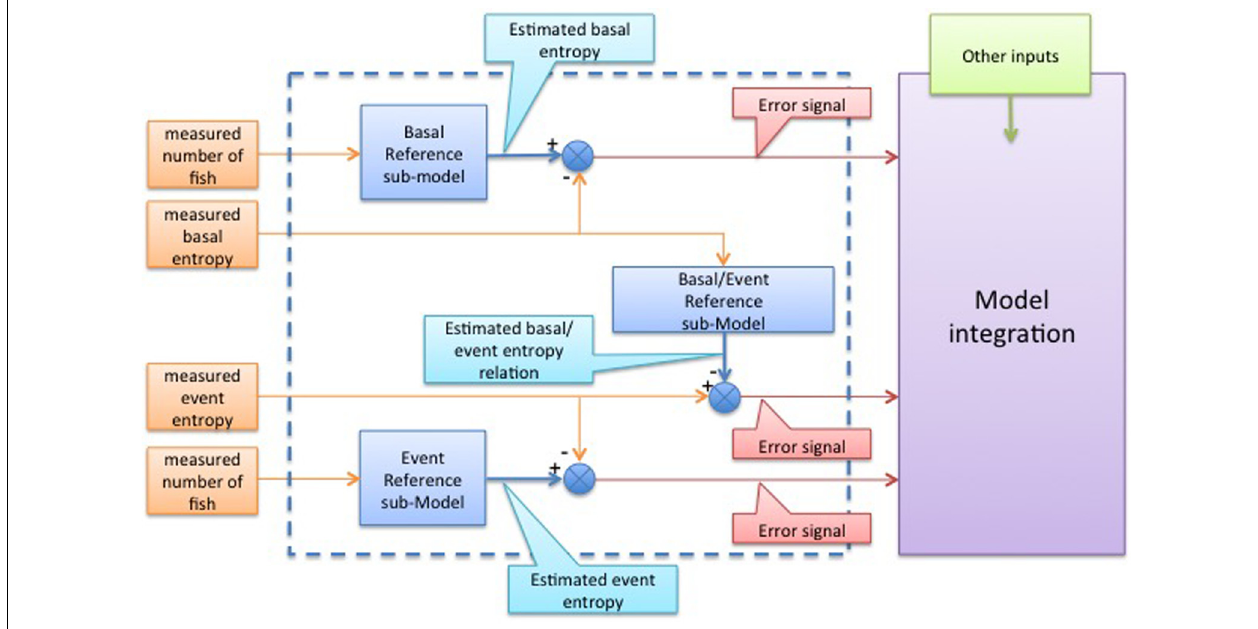
FIGURE 8 | Schematic representation of the model defining inputs, generated outputs due to error signals, internal variables, and sub-model interactions. The output error signals should feed the subsequent phase of the model where all this information is integrated in the Model Integration